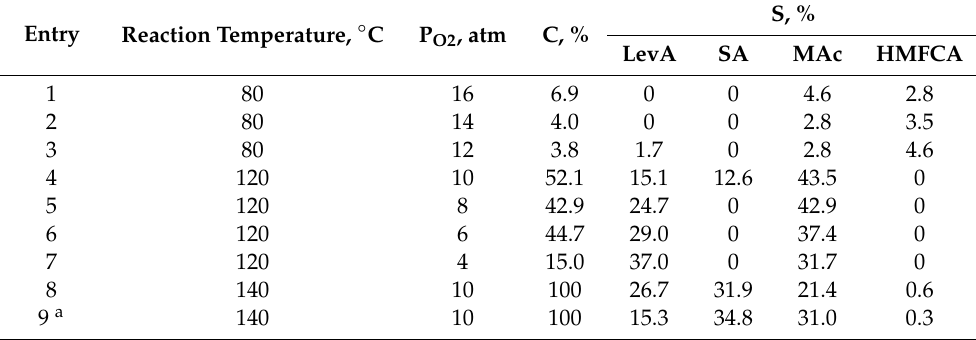
Table 3. The variation of the HMF conversion (C, %) and selectivites (S, %) to the main reaction products in the aqueous oxidation of HMF on the Nb-BEA18 zeolite catalyst.